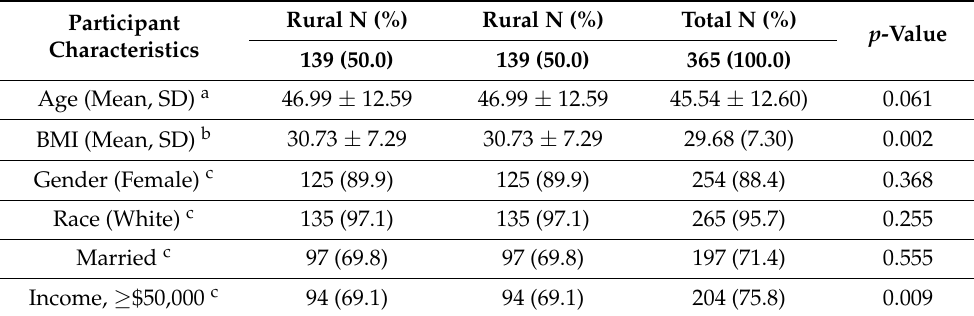
Table 1. Participant demographics split by rurality